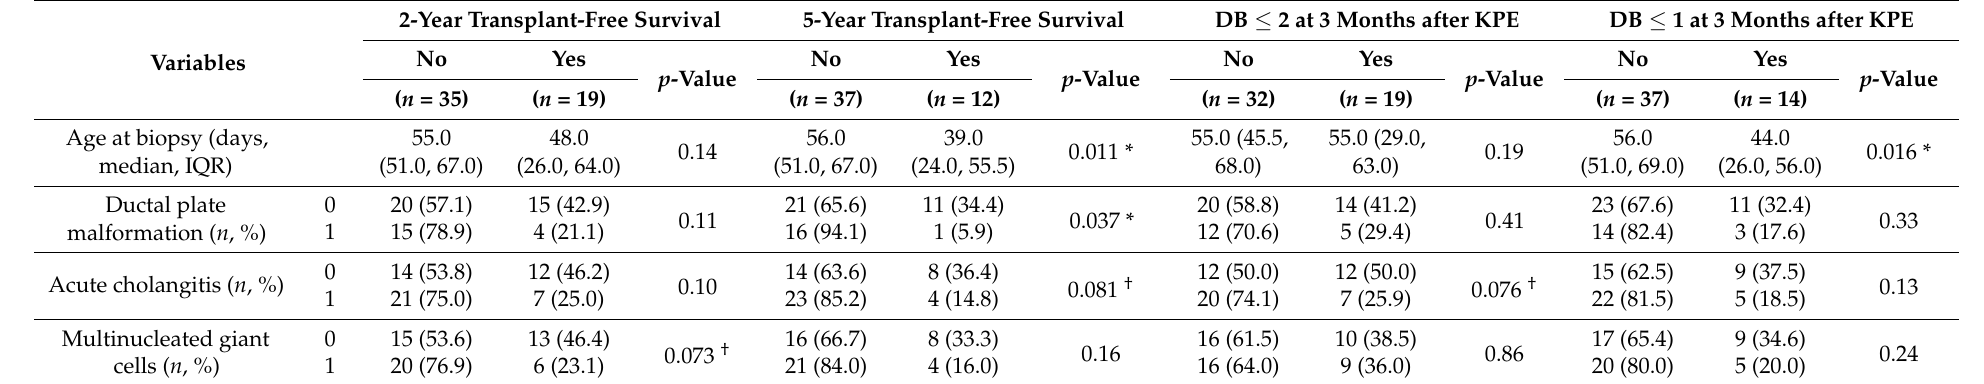
Table 3. Univariate analysis of clinical and histologic factors, binary scoring system. (Legend: DB: Direct bilirubin; KPE: Kasai portoenterostomy; (*): p value < 0.05 statistically significant; (†): p value < 0.1, statistical trend).